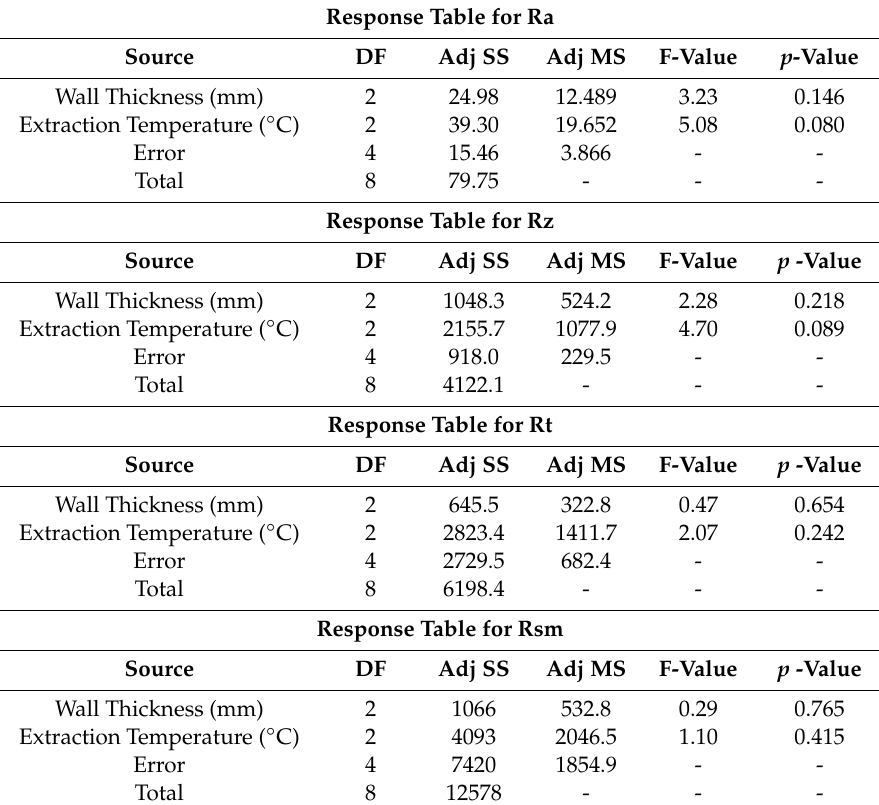
Table 9. ANOVA for surface roughness